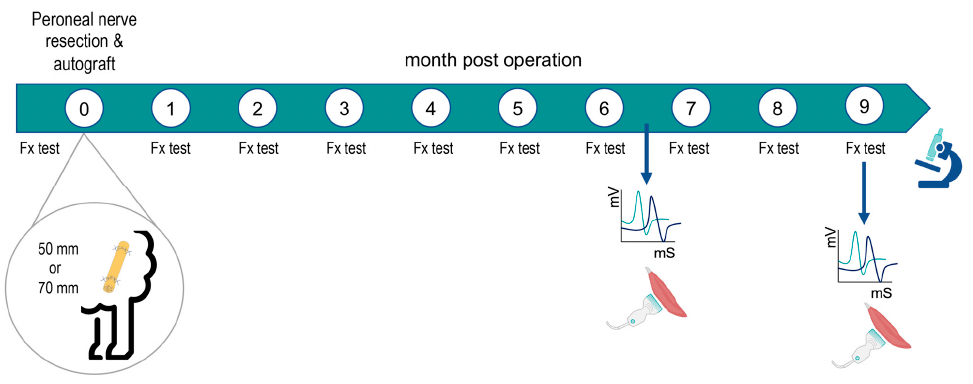
Figure 7. Schema of the design of the study. Following the surgery, functional tests (Fx test) were performed each month, electrophysiological tests and echography were made at 6.5 and 9 months, and samples were taken for histology at the end of the follow-up. Both operated and contralateral hindlimbs were tested at each interval.